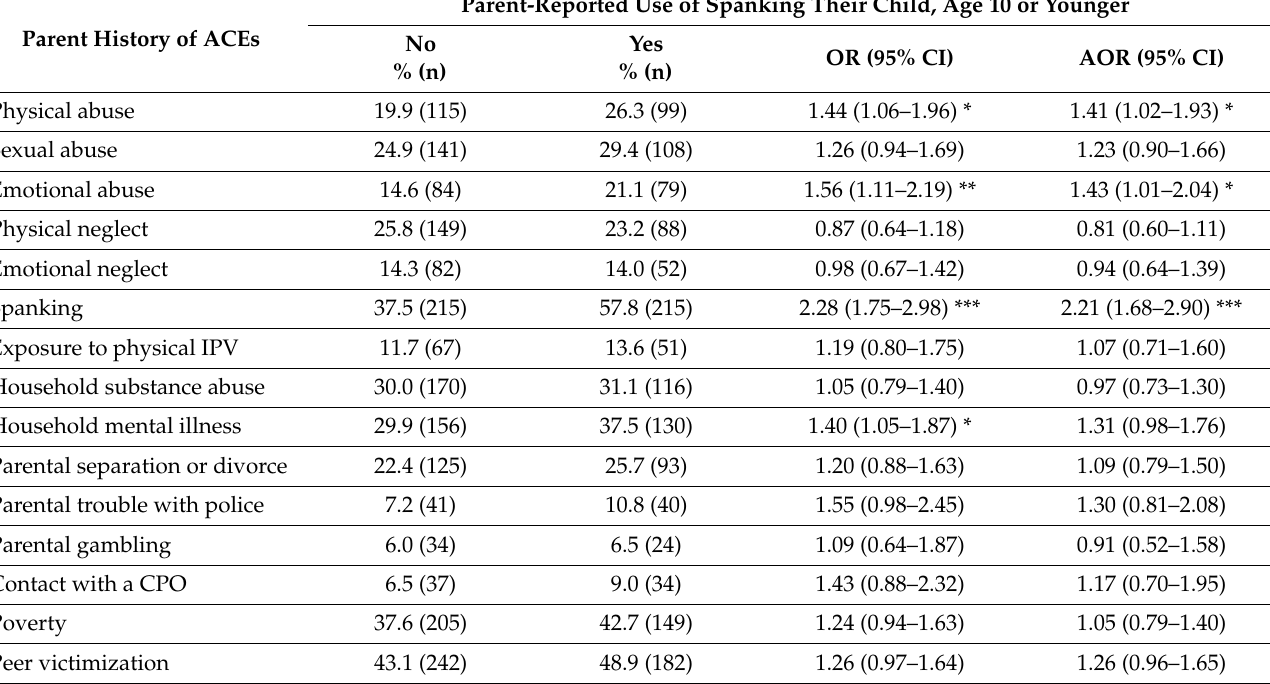
Table 2. Associations between parents’ history of ACEs and parent-reported